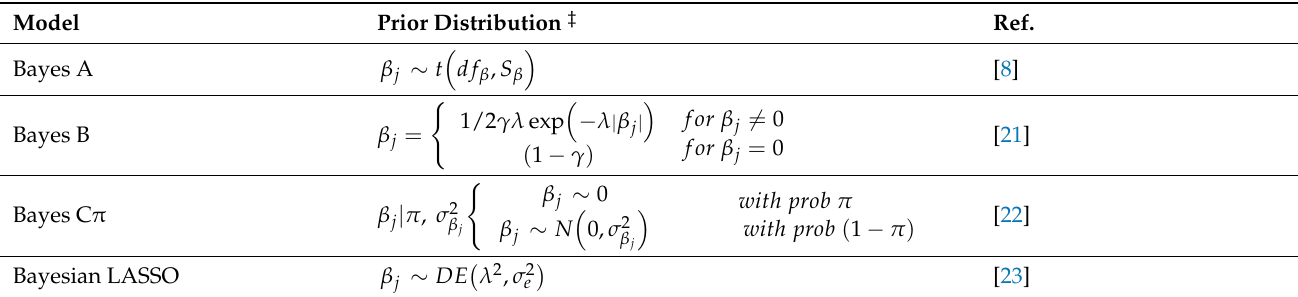
Table 1. Different prior distributions for Bayesian